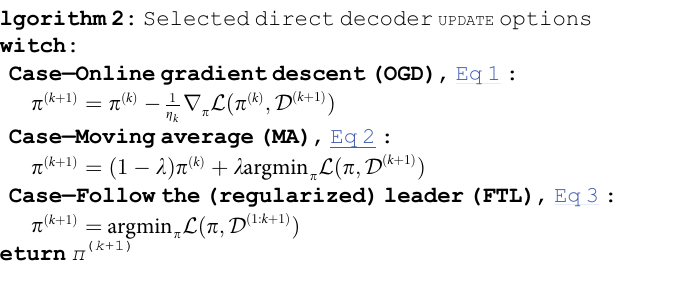
Algorithm 2: Selected direct decoder UPDATE